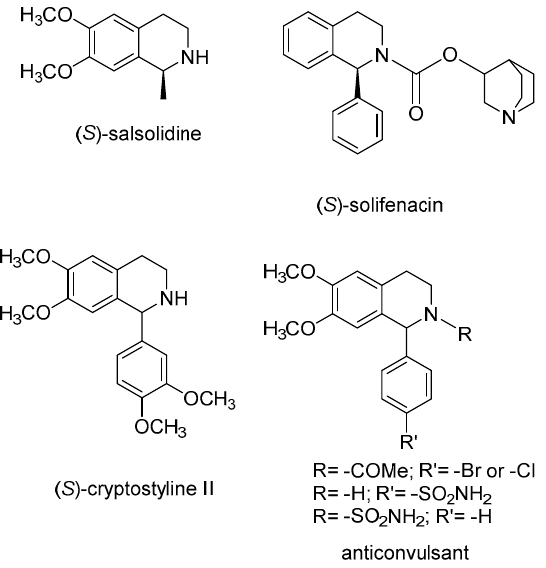
Figure 1. Representative bioactive compounds based on tetrahydroquinolines